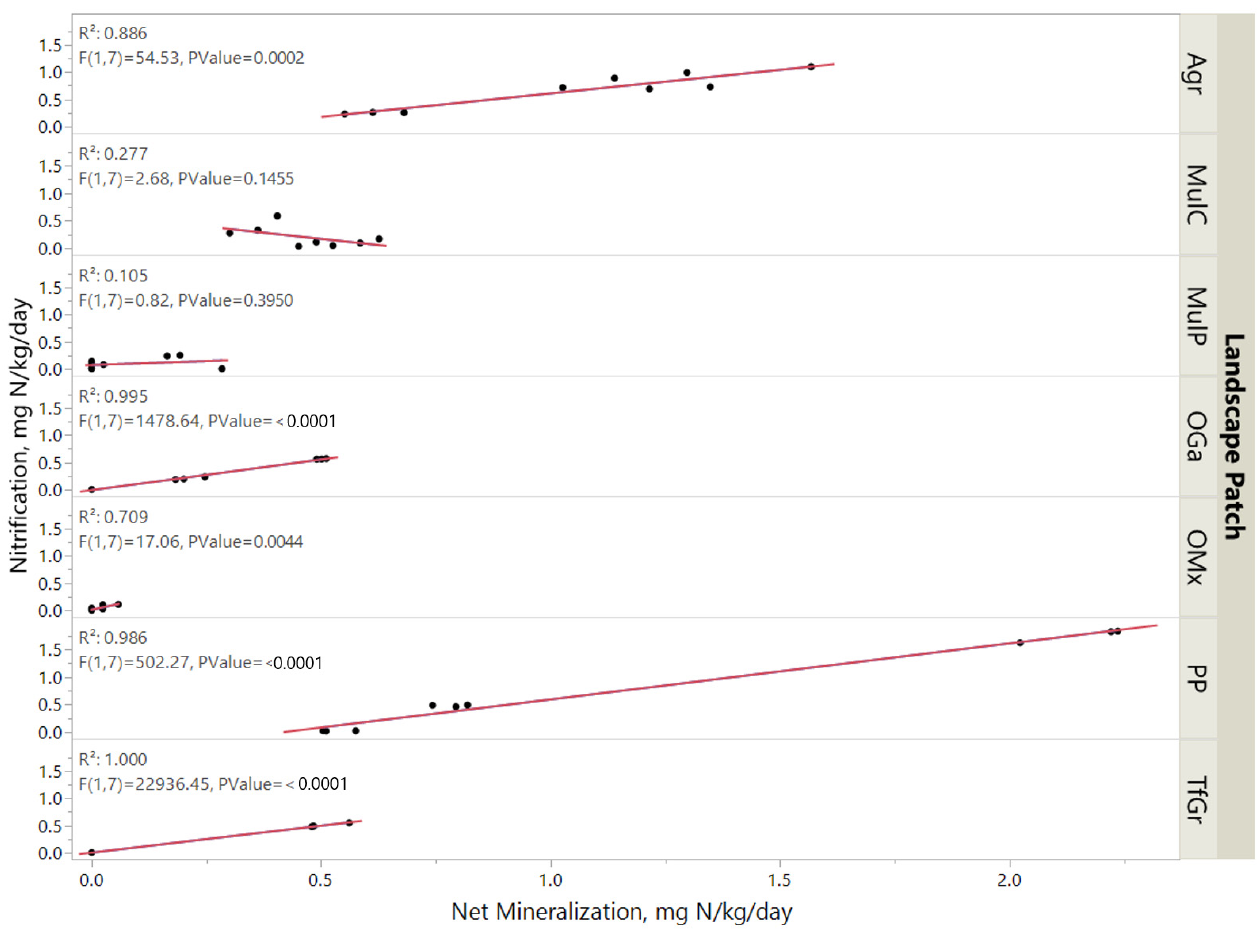
Figure 2. Regressions of nitrification against net N mineralization in the landscape patches, on a whole-core basis. Agr; remnant agricultural field, TfGr; turfgrass, PP; perennial peanut, OMx; patch with a mixture of ornamental grasses, OGa; patch with gamma grass, MulP; patch with pine needle mulch, MulC; patch with pine bark nuggets.